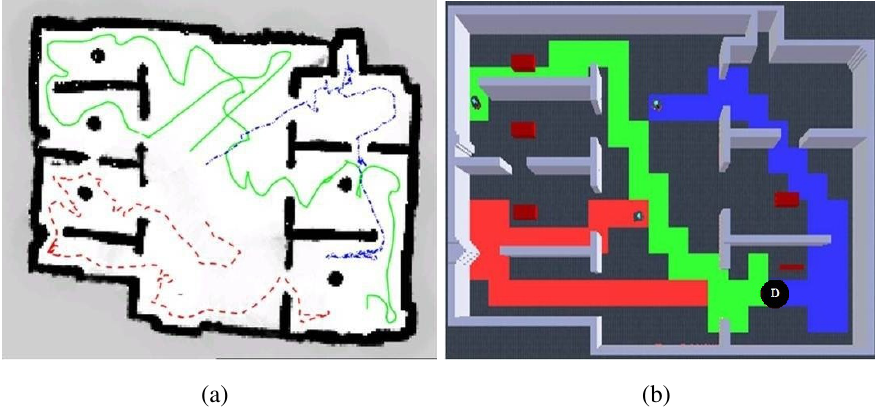
Figure 8. Qualitative appreciation: ( a ) Navigation results from Burgard’s work [1]; ( b ) Our gathered results. Path is drawn in red, green and blue for each robot. High similarity with a much simpler algorithm can be appreciated. Black circle with D indicates deployment point.